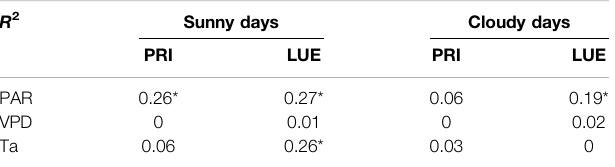
TABLE 2 | Comparison of responses of PRI and LUE to environmental factors in the sunny and cloudy days. R